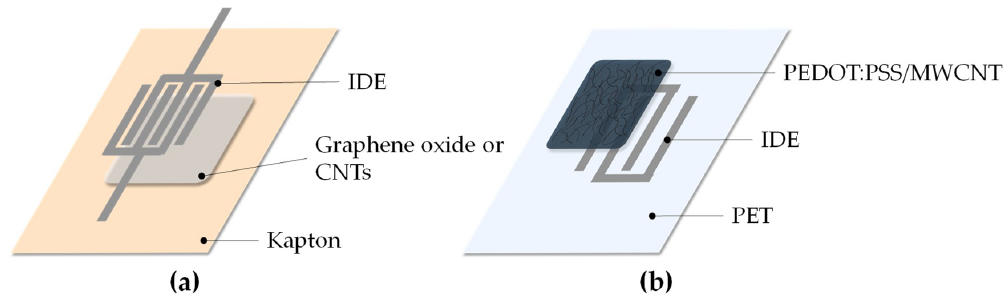
Figure 5. All inkjet-printed chemical gas sensor based on: ( a ) Graphene oxide or CNTs [31]; ( b ) PEDOT:PSS/ MWCNT) [51].